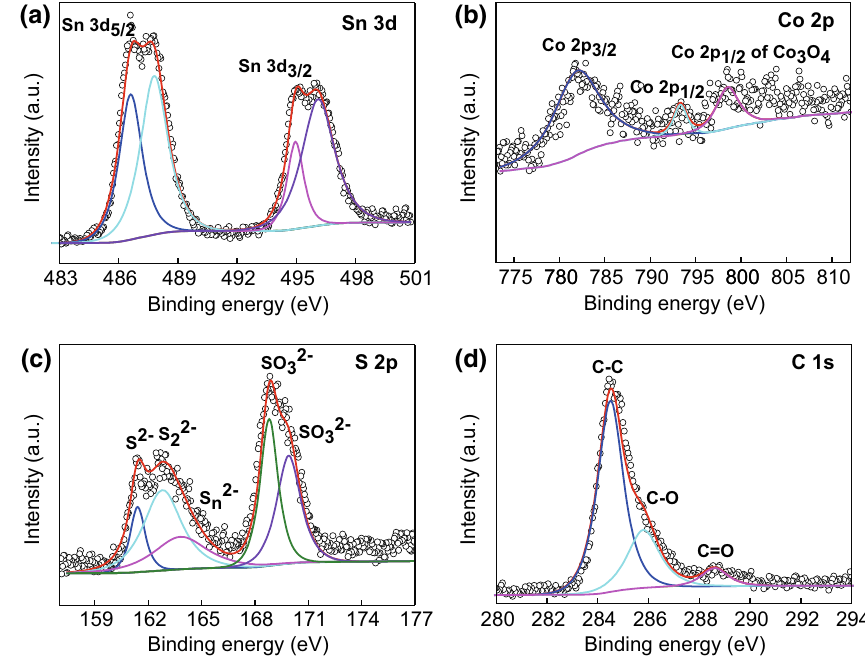
Fig. 2 XPS spectra of a Sn 3d, b Co 2p, c S 2p and d C 1s core levels of the SnS 2 @CoS 2 –rGO